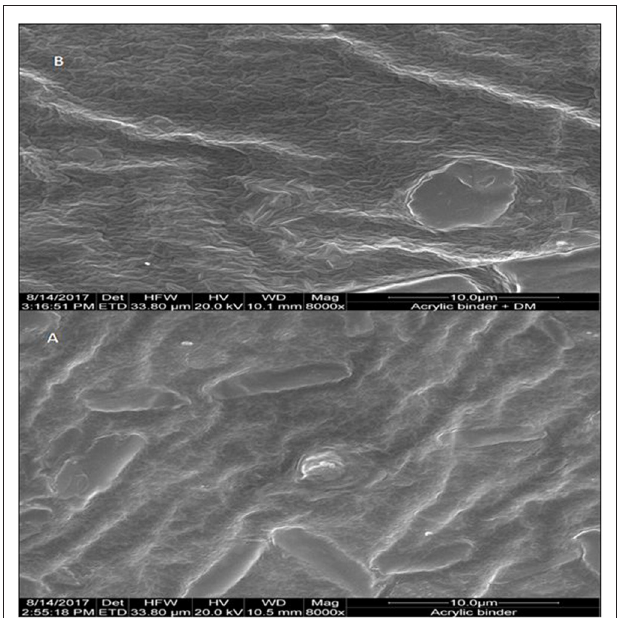
FIGURE 4 | E SEM micrographs of binders without deltamethrin P12 (A) and with deltamethrin PS002 (B) .